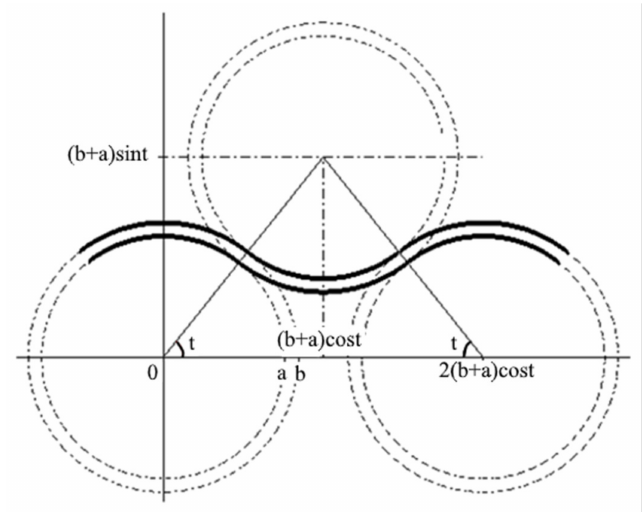
Figure 10. Scheme for joining